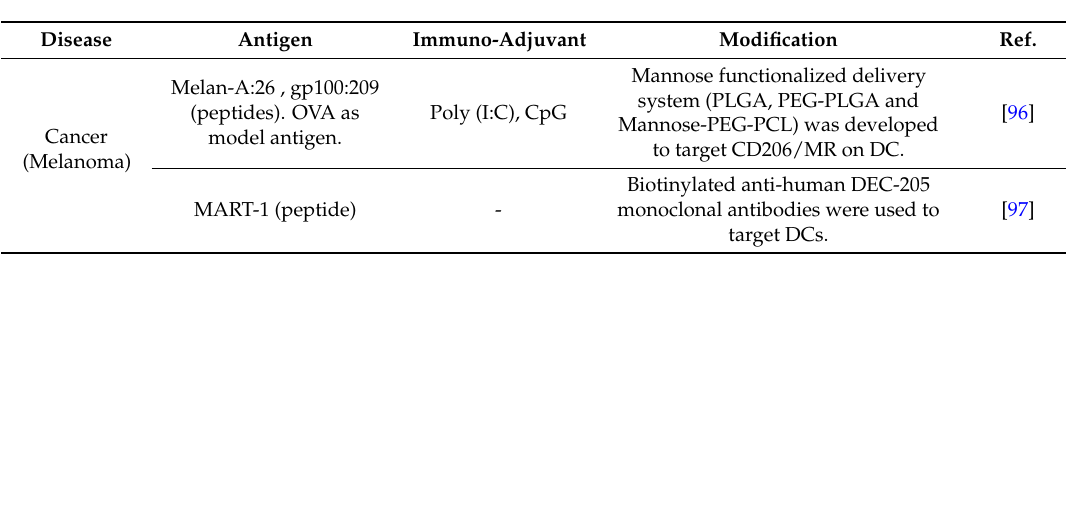
Table 4. Modifications of PLGA nanoparticles for vaccine